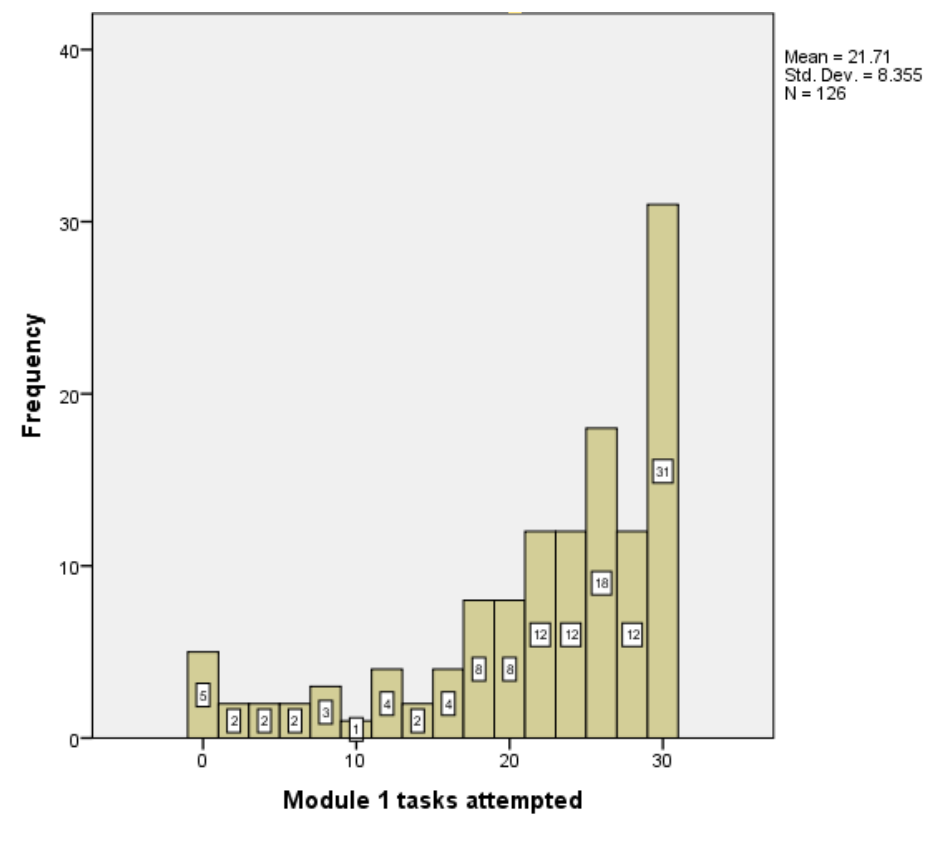
Figure 1: Distribution of knowledge check quiz completions in Module